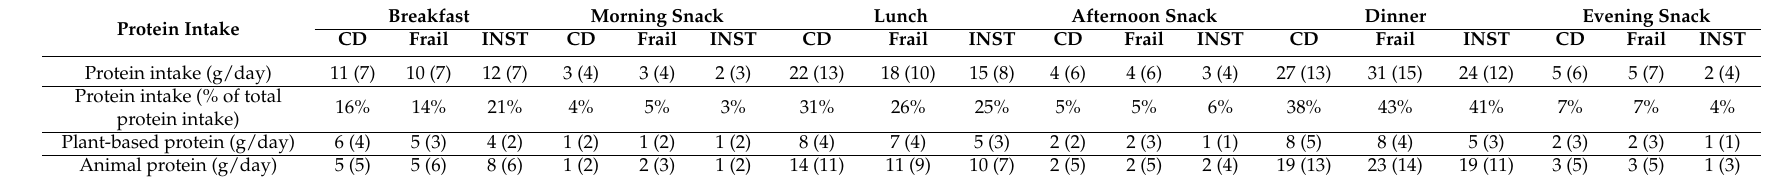
Table 2. Dietary protein intake of community-dwelling, frail and institutionalized elderly people distributed throughout the